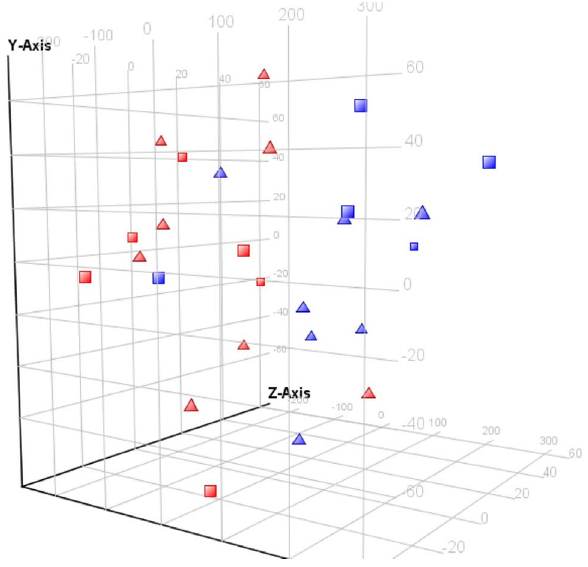
Figure 3. Principle component analysis of 26 transplant recipients using 1936 significantly correlated transcripts with weight change. Approximately 64%, 17% and 10% of the variability was attributed to principle components 1, 2, and 3, respectively. Legend: weight change great . 5% at 6 months post-transplantation, Red ; Weight change , 5% at 6 months post-transplantation, blue ; Male, square ; Female, triangle .